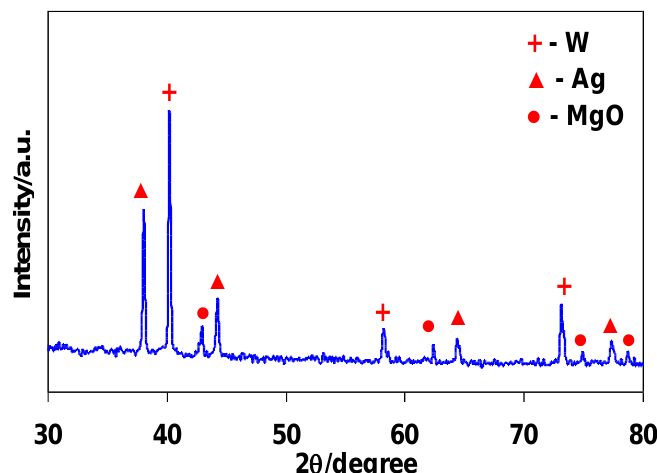
Figure 8. XRD analysis results of the Ag 2 WO 4 + 2Mg + 1.7C mixture after heating, T = 1300 °C.